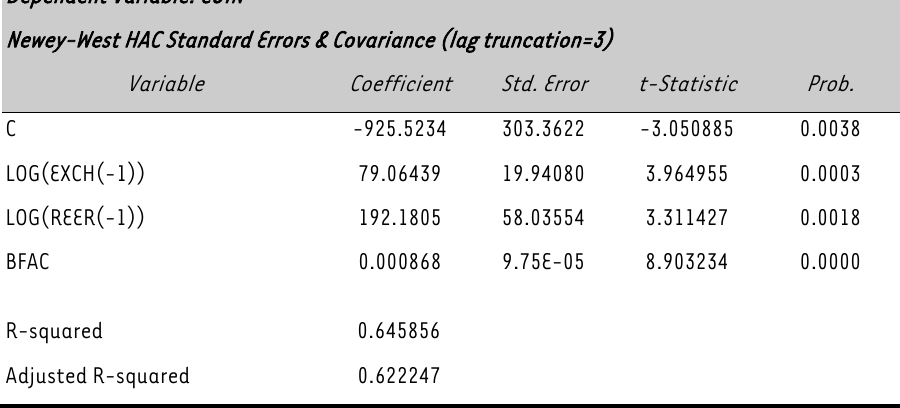
TABLE 3: Regression results for the capital component Dependent Variable: